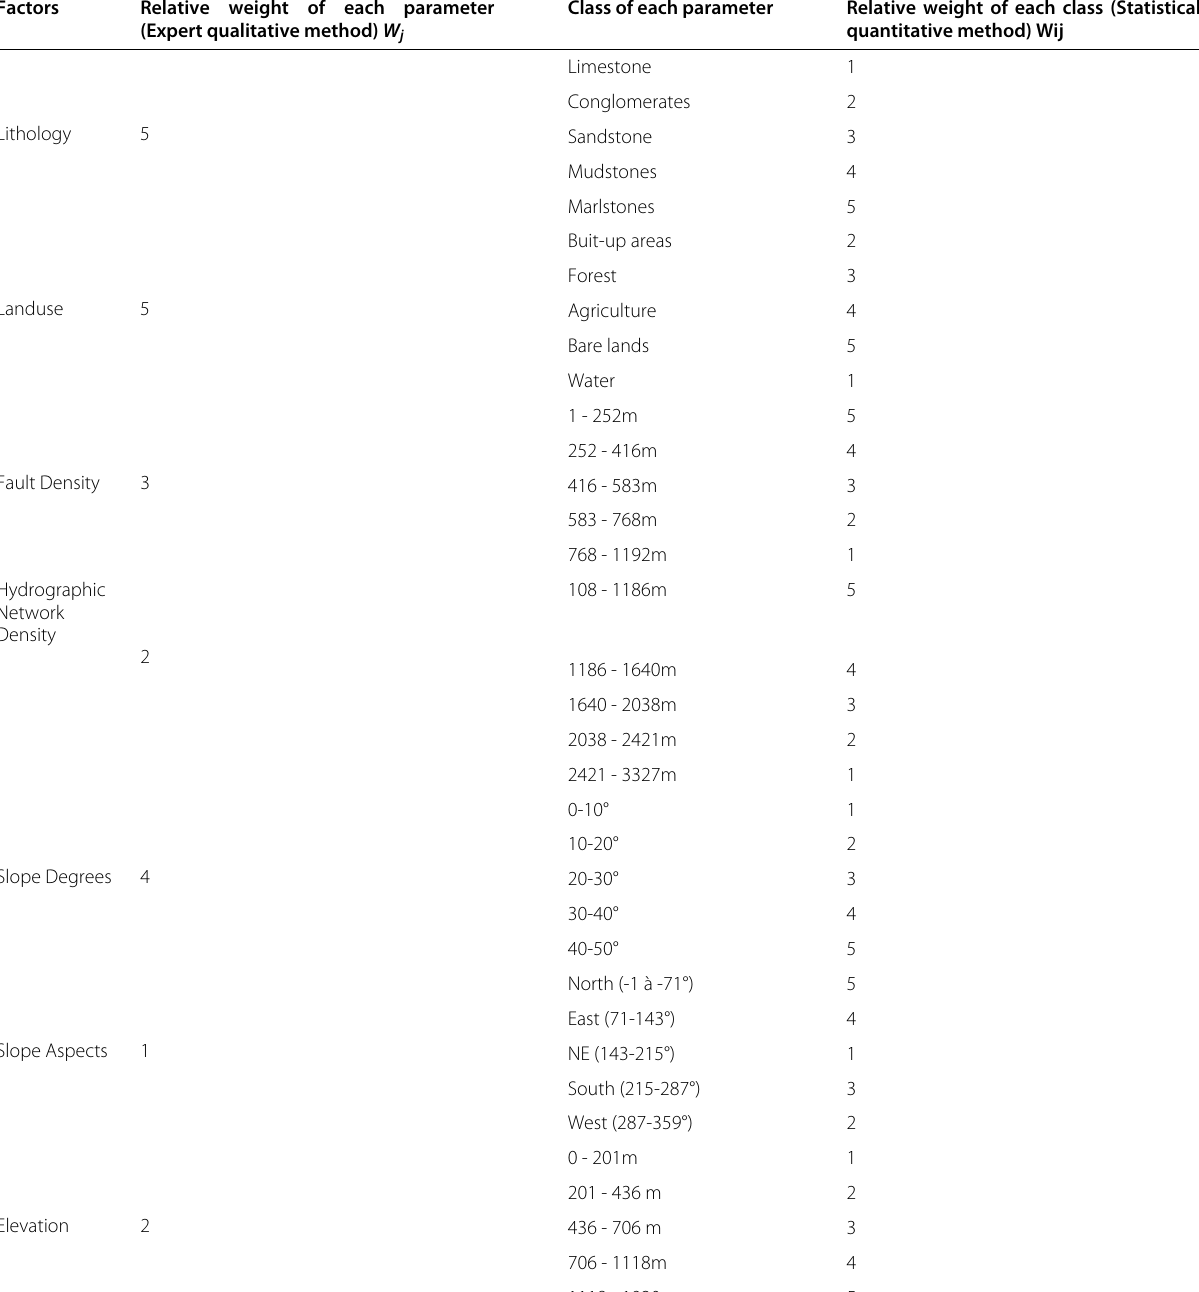
Table 1 Relative weights of the each parameter ( W j ) and relative weight of different classes ( w ij ) influencing the MM genesis in the province of Tétouan Factors Relative weight of each parameter (Expert qualitative method) W j